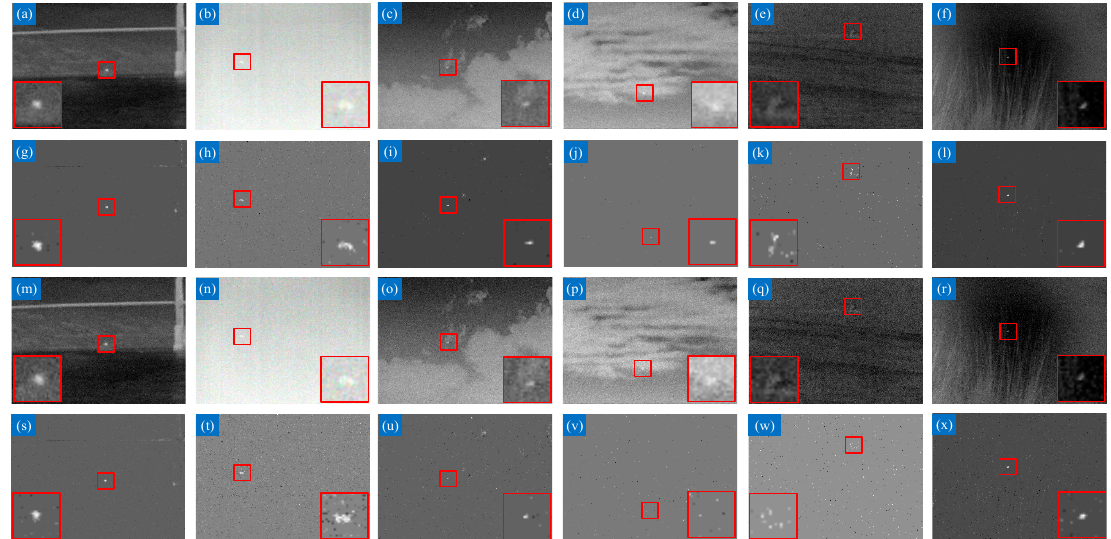
Figure B2. The first and third row show infrared images with additive white Gaussian noise with standard deviation of 10 and 20, and the second and fourth rows are the corresponding detection results by NIPPS.